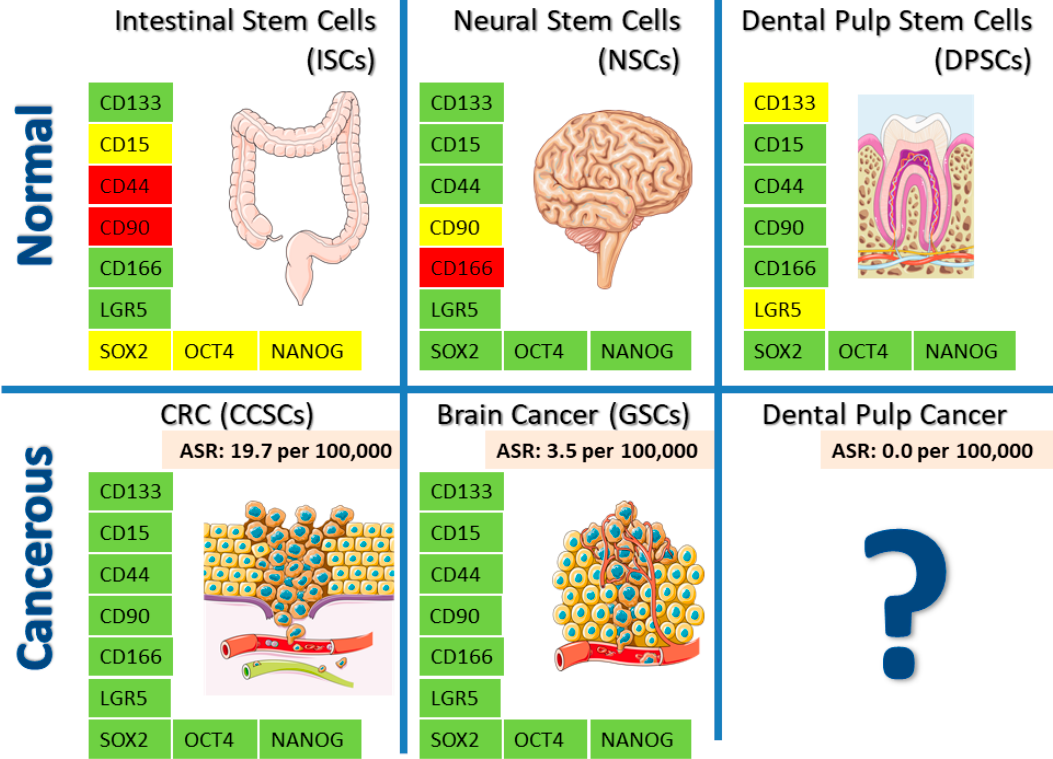
Figure 2. Comparison between ISCs, NSCs and DPSCs and their corresponding CSC derivatives. For the sake of simplicity, only markers with a di ff erential expression are shown. Many of the markers expressed by gut and brain CSCs are also shared by normal healthy DPSCs, with the cases of CD133 and LGR5 as the only yet unknown exceptions. Healthy NSCs and DPSCs share at least 7 di ff erential markers each with CSCs. ISCs show far fewer coincidences with CSCs in terms of marker presence / absence. Despite the great similarity in marker expression between di ff erent CSCs and DPSCs, there exist absolutely no reports showing phenotypes of CSCs originating in the dental pulp, and dental pulp cancer incidence worldwide is 0%. Markers in green color: confirmed expression. Markers in red color: confirmed absence of expression. Markers in yellow color: Not well defined or unknown expression. The yearly worldwide incidence of each cancer type for 2018 is expressed as Age Standardized Rates (ASR) per 100,000 people (pink color), as reported in [228] and [229]. Images credit: Creative Commons License Servier Medical Art by Servier (https: // smart.servier.com / ). All central nervous system cancers are considered within brain cancer rate. CRC: colorectal cancer. CCSCs: colorectal cancer stem cells. GSC: glioblastoma stem